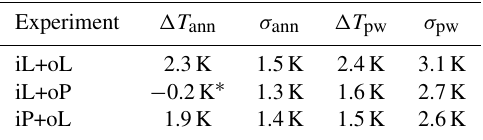
Table 2. Annual mean ( T ann ) and precipitation-weighted ( T pw ) temperature change relative to iP+oP and associated standard de- viations ( σ ann , σ pw ) for